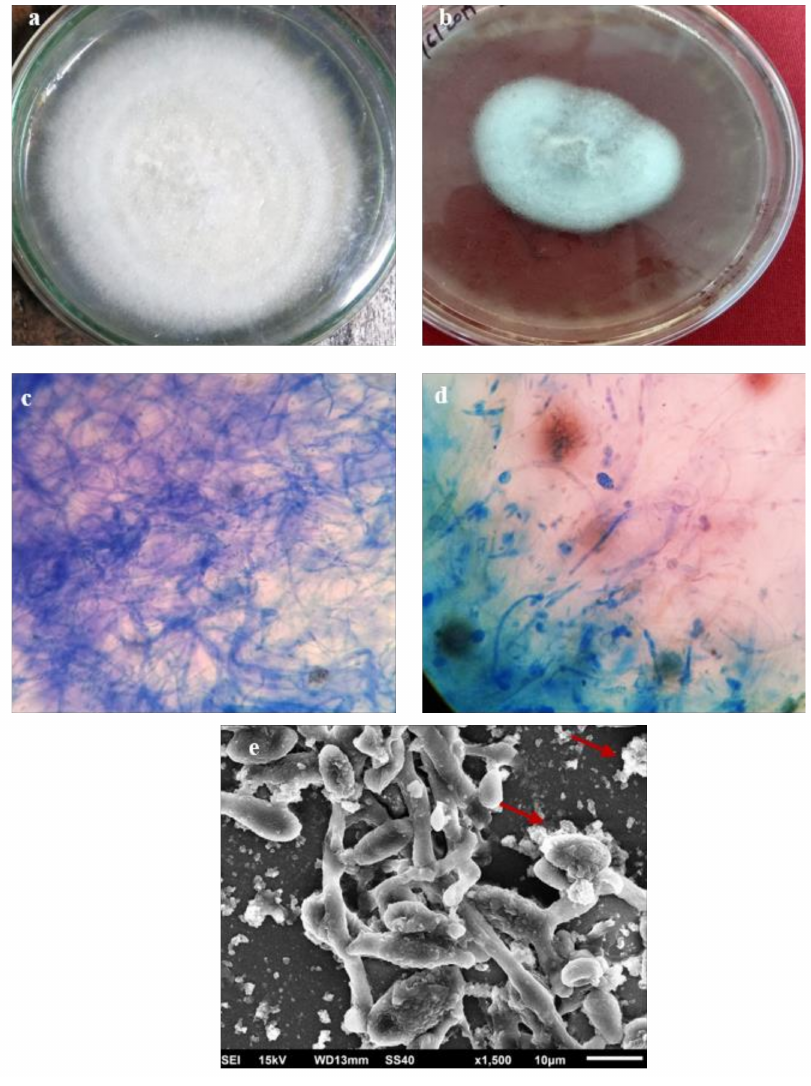
Figure 6. Antifungal activity, ( a ) F. oxysporum on PDA media without AgNPs, ( b ) F. oxysporum on PDA media with AgNPs, ( c ) fungal mycelium and, ( d ) fungal mycelium treated with AgNPs, and ( e ) SEM image showing ruptured fungal mycelium by